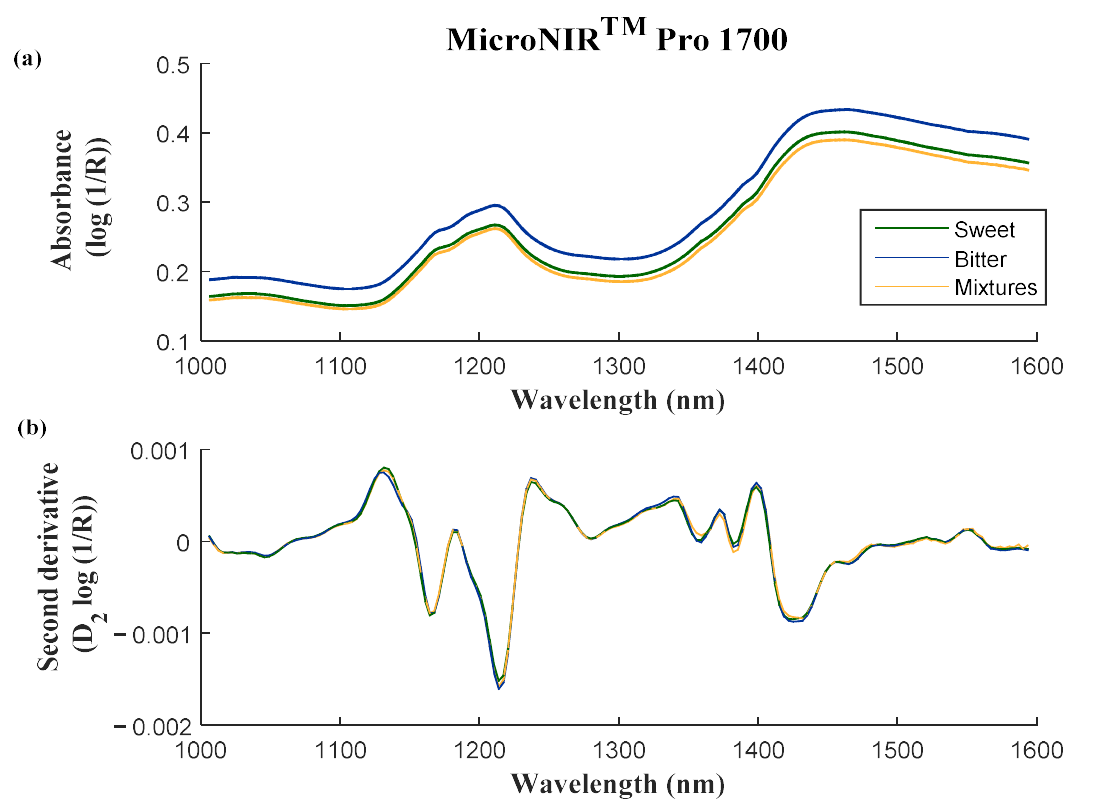
Figure 1. Absorbance ( a ) and second derivative spectra ( b ) of the different groups of samples analysed (sweet, bitter and mixtures). Table 1. Discriminant models for classifying sweet almond batches by bitterness using the mean